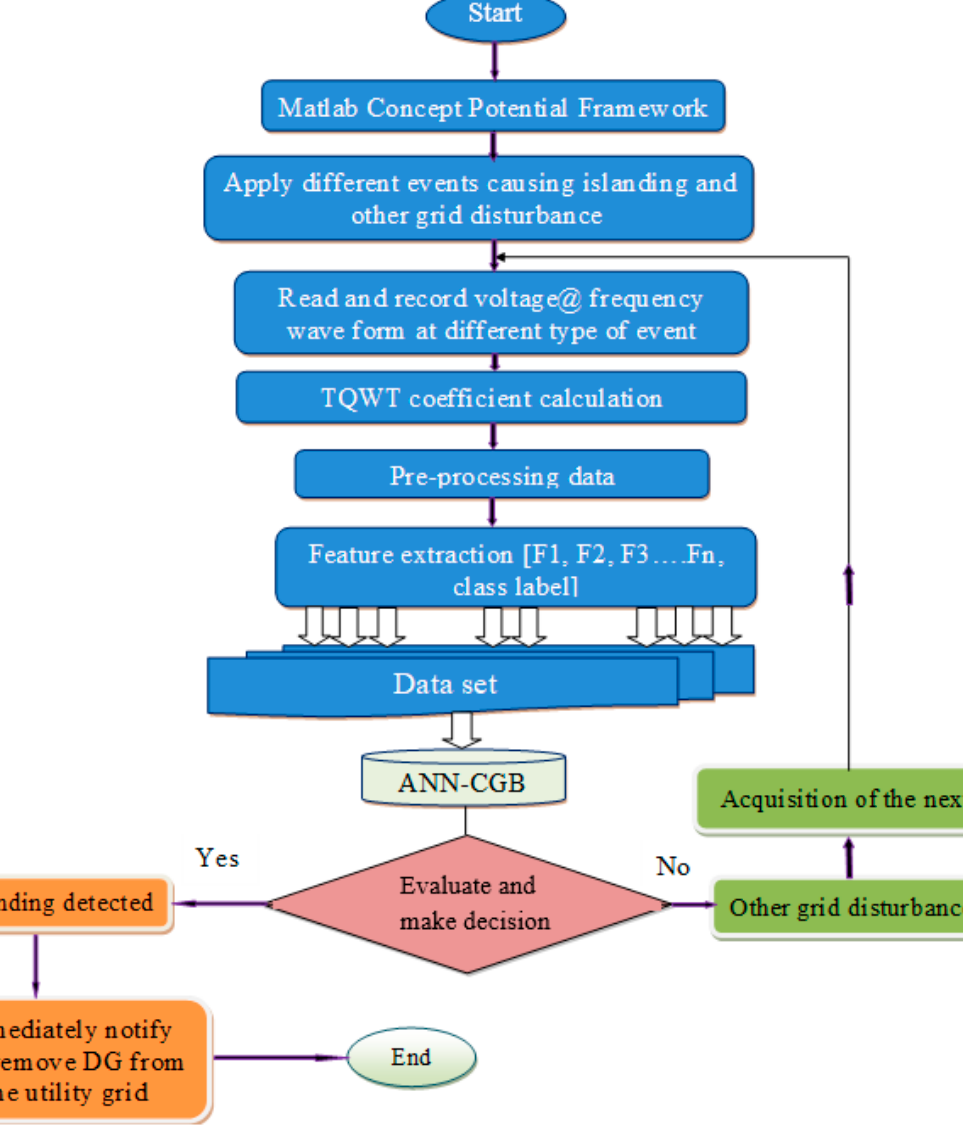
Figure 8. The scheme of the suggested ANN-based TQWT technique for islanding detection.